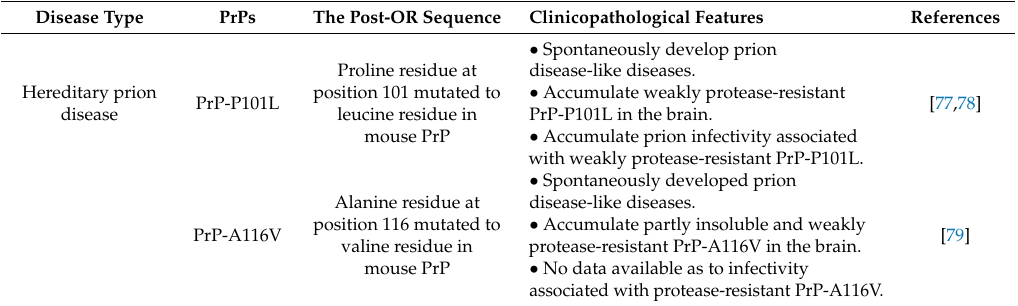
Table3. Effectsofvariousmutationsinthepost-ORregionofPrP C onhereditaryandacquiredpriondiseases. Disease